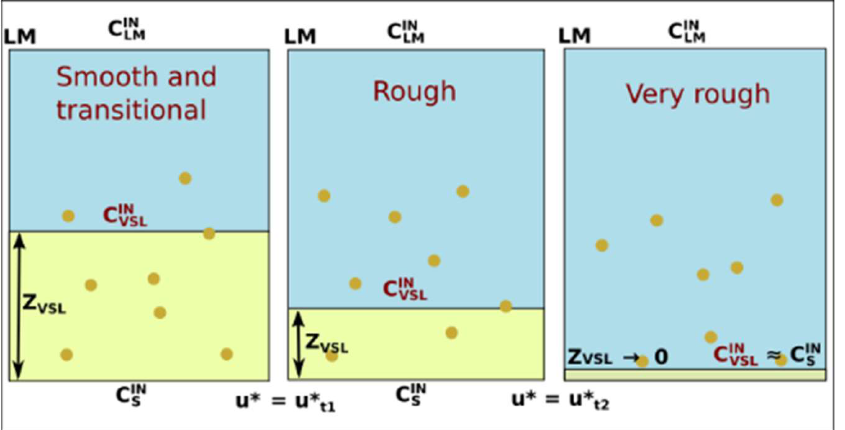
Figure 5. Schematic description of the viscous sub–layer concept. Emission under smooth and transitional regime happens for small u ∗ when VSL is the thickest. In the rough mixing regime, the near-surface turbulence increases, and the VSL depth decreases. Under fully developed turbulent conditions (very rough regime), emission reaches its maximum, and VSL depth vanishes.